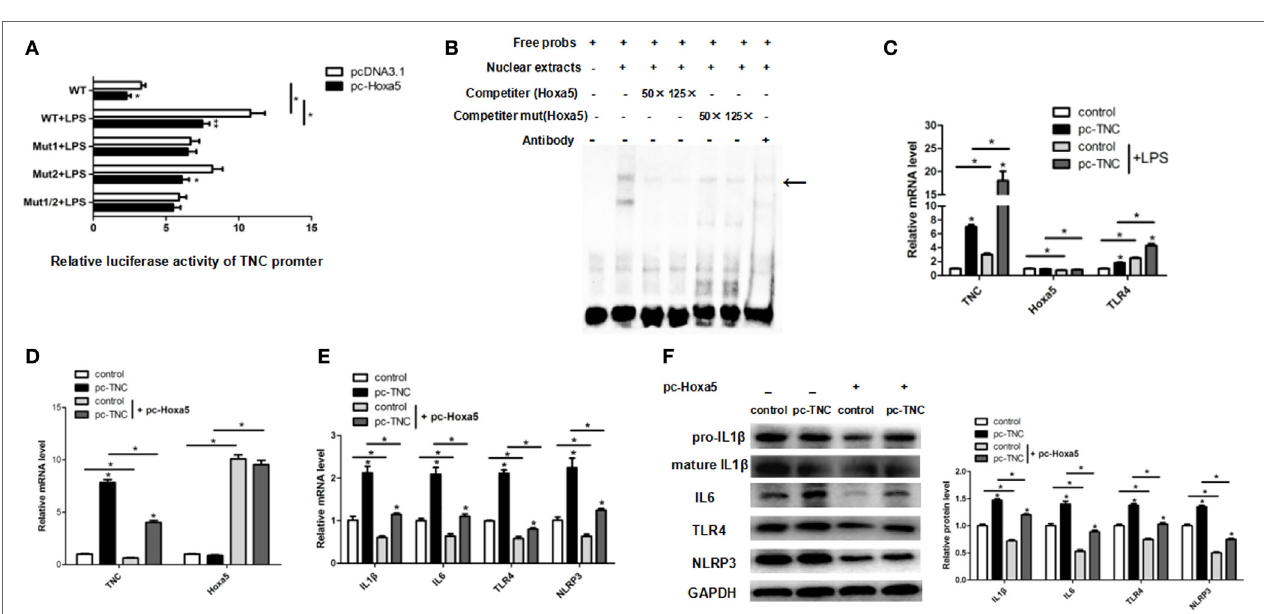
FigUre 6 | Homeobox a5 (Hoxa5) represses adipocytes inflammation by negative transcription regulation of tenascin C (TNC). (a) Mutational fragments of TNC promoter in a luciferase reporter vector in pc-control or pc-Hoxa5 groups ( n = 4). (B) Electrophoretic mobility shift assay showing direct binding of Hoxa5 to TNC promoter in vitro . The main complexes are marked with arrows. (c) Relative mRNA expression level of TNC, Hoxa5, and Toll-like receptor (TLR) 4 in mice adipocytes in pc-control, pc-Hoxa5, and sh-Hoxa5 group with or without lipopolysaccharide (LPS) treatment ( n = 4). (D,e) Relative mRNA expression level of TNC, Hoxa5, IL1 β , IL6, TLR4, and NLRP3 in mice adipocytes co-treatment with pc-TNC and pc-Hoxa5 under LPS treatment ( n = 4). (F) immunoblots images for IL1 β , IL6, TNF α , and NLRP3 in mice adipocytes co-treatment with pc-TNC and pc-Hoxa5 under LPS treatment ( n = 4). Values are represented as means ± SD vs. control group, * p < 0.05.